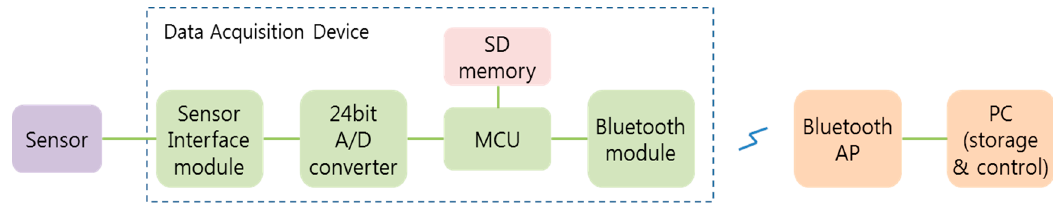
Figure 4. The structural health monitoring system.